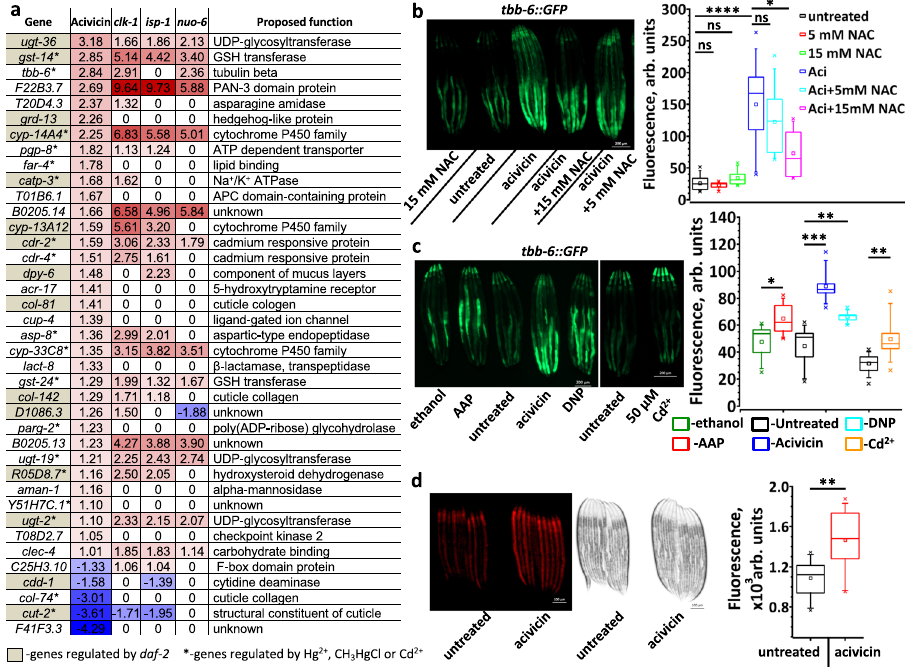
Fig. 6 GSH restriction upregulates mitochondrial ROS signaling in C. elegans . a Genes induced by acivicin and by life-extending mitochondrial mutations overlap signi fi cantly. Numbers represent the expression log 2 fold change compared to wt or untreated worms. See full list of differentially regulated genes in Supplementary Data 2. Data for gene expression in daf-2 , clk-1 , isp-1 and nuo-6 are from 32 . Up- and down-regulated genes are indicated, respectively, in red and blue. Genes which are regulated in daf-2 worms are highlighted in gray. *-genes regulated by Hg 2 + , CH 3 HgCl or Cd 2 + . Statistical signi fi cance for the overlap between sets upregulated more than two folds by: acivicin (34 genes) and nuo-6 (1285 genes) – 22 genes overlap, RF = 10.3, p value = 7.93e − 19; acivicin and clk-1 (328 genes) – 13 genes overlap, RF = 23.9, p value = 2.48e − 15; acivicin and isp-1 (609 genes) – 19 genes overlap, RF = 18.8, p value = 9.01e − 21. RF – representation factor is the number of overlapping genes divided by the expected number of overlapping genes and p is normal approximation of hypergeometric probability. b , c Representative fl uorescent images (left panels) and quanti fi cations (right panels) demonstrating the tbb-6 counter-regulation by acivicin ( n = 70) and NAC ( n = 30-55) ( b ) and the tbb-6 induction by acetaminophen (AAPh, 20mM, n = 35), acivicin (75 µ M, n = 35), dinitrophenol (DNP, 100 µ M, n = 35), and cadmium (Cd 2 + , 50 µ M, n = 65) ( c ). L4 stage worms were transferred to plates supplemented with chemicals as indicated, and incubated for 24h at 20°C before imaging. n = 30 – 70 worms over three independent experiments. See also Supplementary Tables 8 and 9. d Representative fl uorescent and bright light images (left panels) and quanti fi cations (right panel) demonstrating mitochondrial ROS staining by MitoTracker CM-H 2 X in control and acivicin-treated worms ( n = 79). Worms developed till stage L3 on control and acivicin supplemented plates. See also Supplementary Table 10. In b , c and d the box plots indicate median (middle line), 25th, 75th percentile (box) and 5th and 95th percentile (whiskers) as well as maximum, minimum and mean (single points). In all graphs p values are: n.s. not signi fi cant; * p <0.05; ** p <0.01; *** p <0.001; **** p <0.0001; two-tailed t